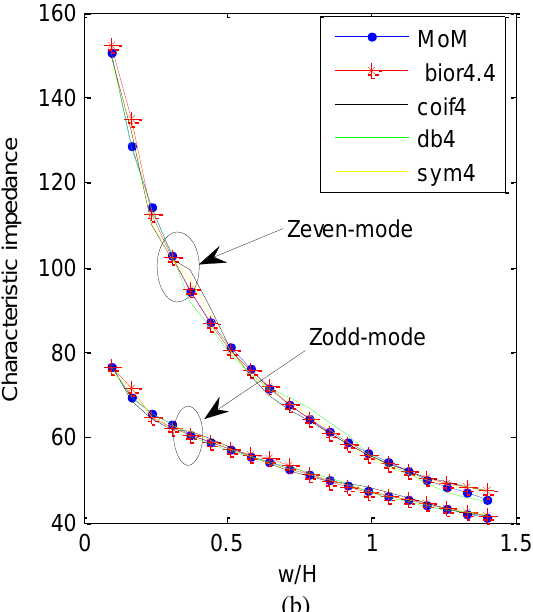
Fig. 9: Characteristic impedance of microstrip line (a) and Even- and odd-mode characteristic impedances for coupled microstrip lines (b).